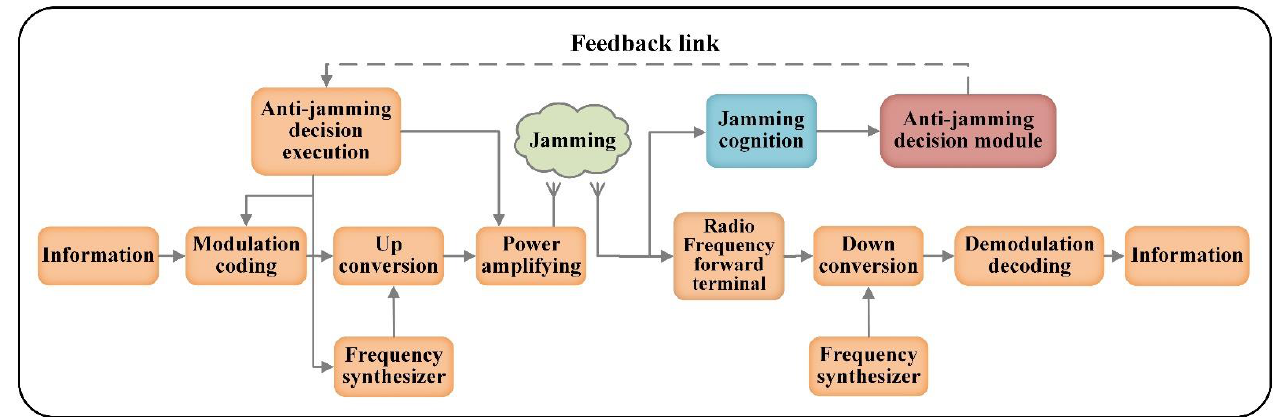
Figure 1. The block diagram of an intelligent anti-jamming communication system model. The anti-jamming decision-making module can also be further refined, as shown in